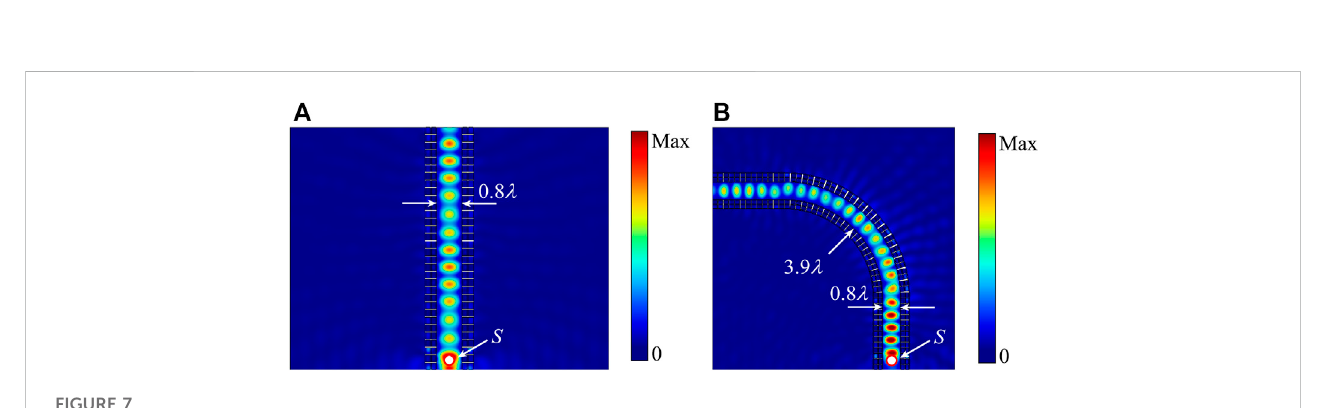
by metasurfaces based on the supercell with m = 2. The white dot with a red circle marks the location of the wave source. The width of the channel is selected smaller than the wavelength as 0 .8 λ to avoid the generation of wave interference [27]. The result shows that the wave is trapped in the channel and propagates straight forward. If the channel is turned to form an “ L ” -shaped channel by metasurfaces, the energy fi eld shows that the wave travels through the channel with high amplitude as shown in Figure 7B. Therefore, for two metasurfaces with omnidirectional re fl ection